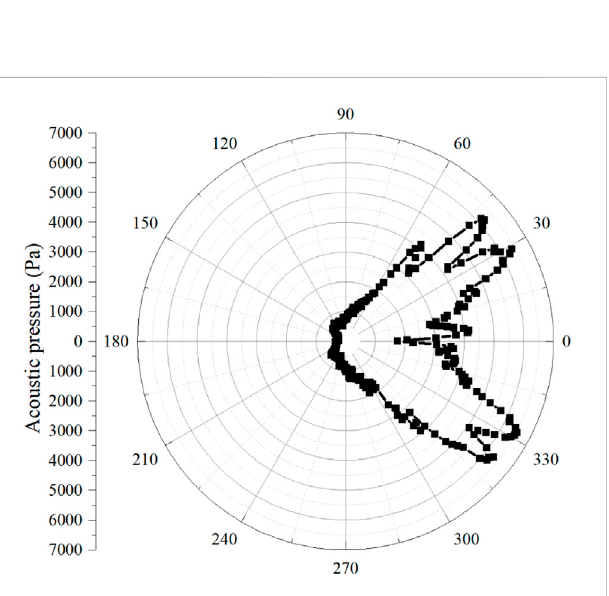
FIGURE 10 Acoustic results for the pressure-based Kirchhoff